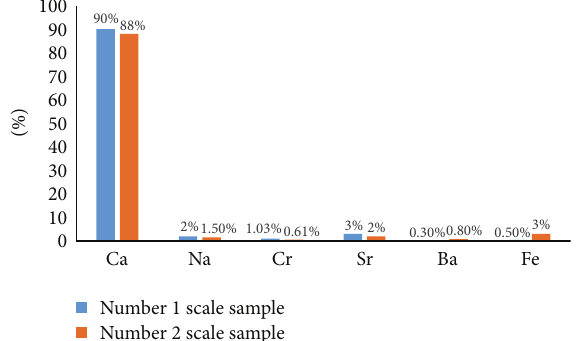
Figure 2: Metal atoms content in number 1 and number 2 scale